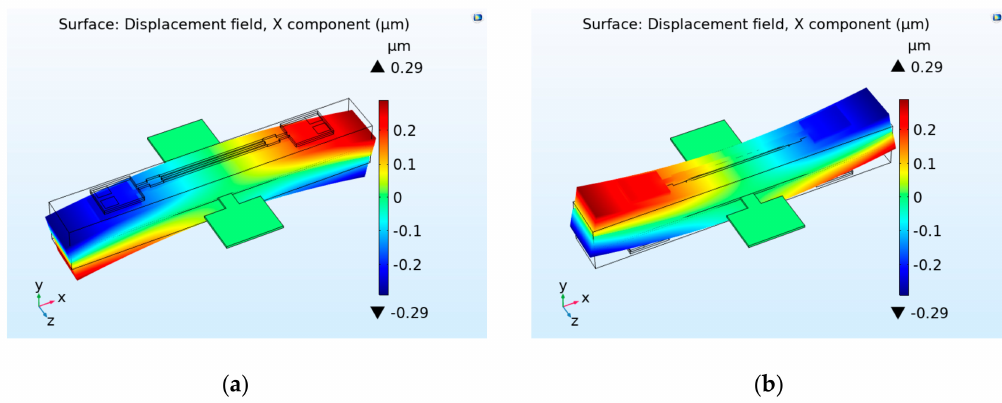
Figure 4. Displacement distribution of the sensor structure under the action of applied voltage of ( a ) + 700 V and ( b ) − 700 V.